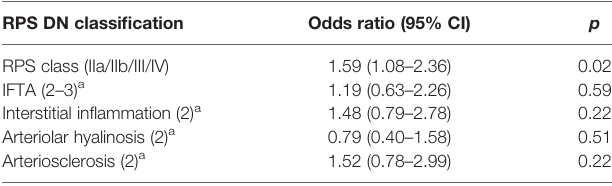
TABLE 3 | Multivariable-adjusted logistic regression analysis for glomerular C3 deposits according to the 2010 RPS DN classi fi cation.